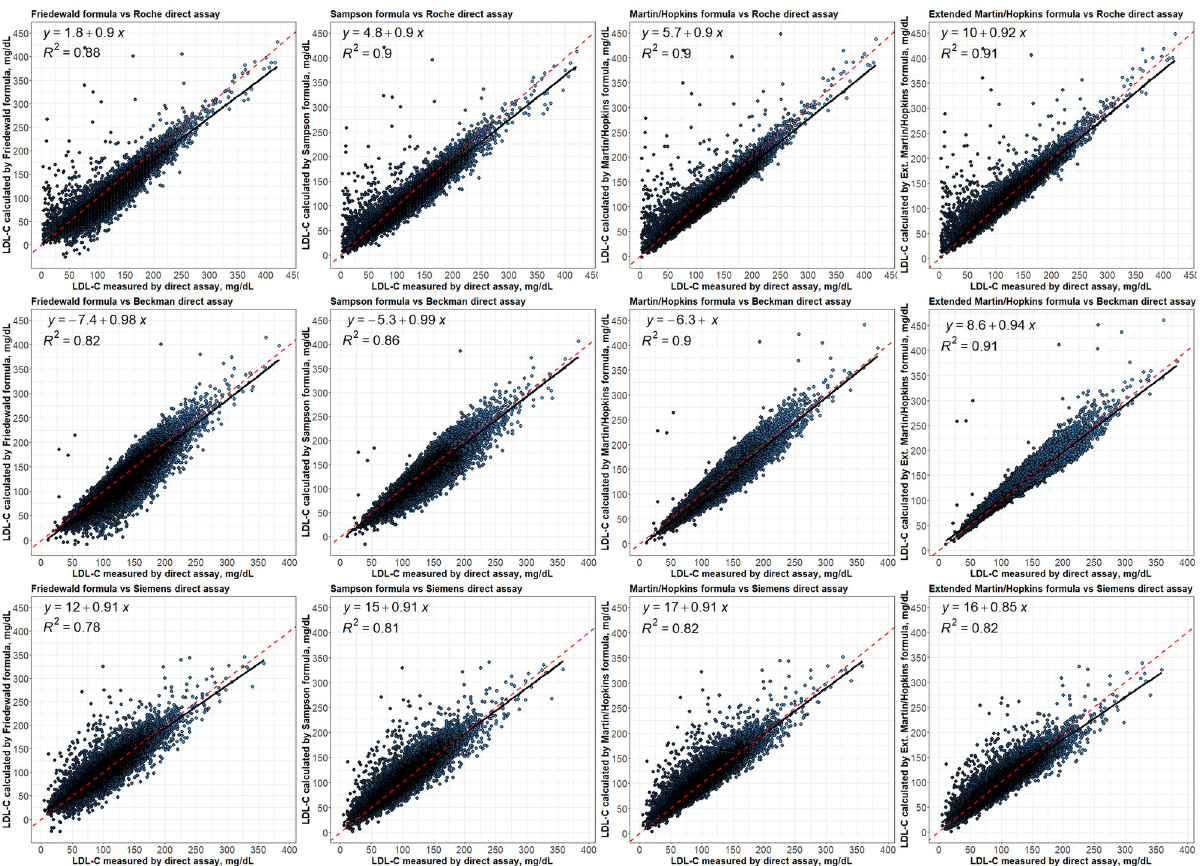
Fig 6. Regression analysis between LDL-C levels estimated by formulas and directly measured LDL-C levels. Correlations of estimated LDL-C levels by Friedewald, Sampson, Martin-Hopkins and extended Martin-Hopkins formulas with LDL-C levels directly measured by Roche, Beckman and